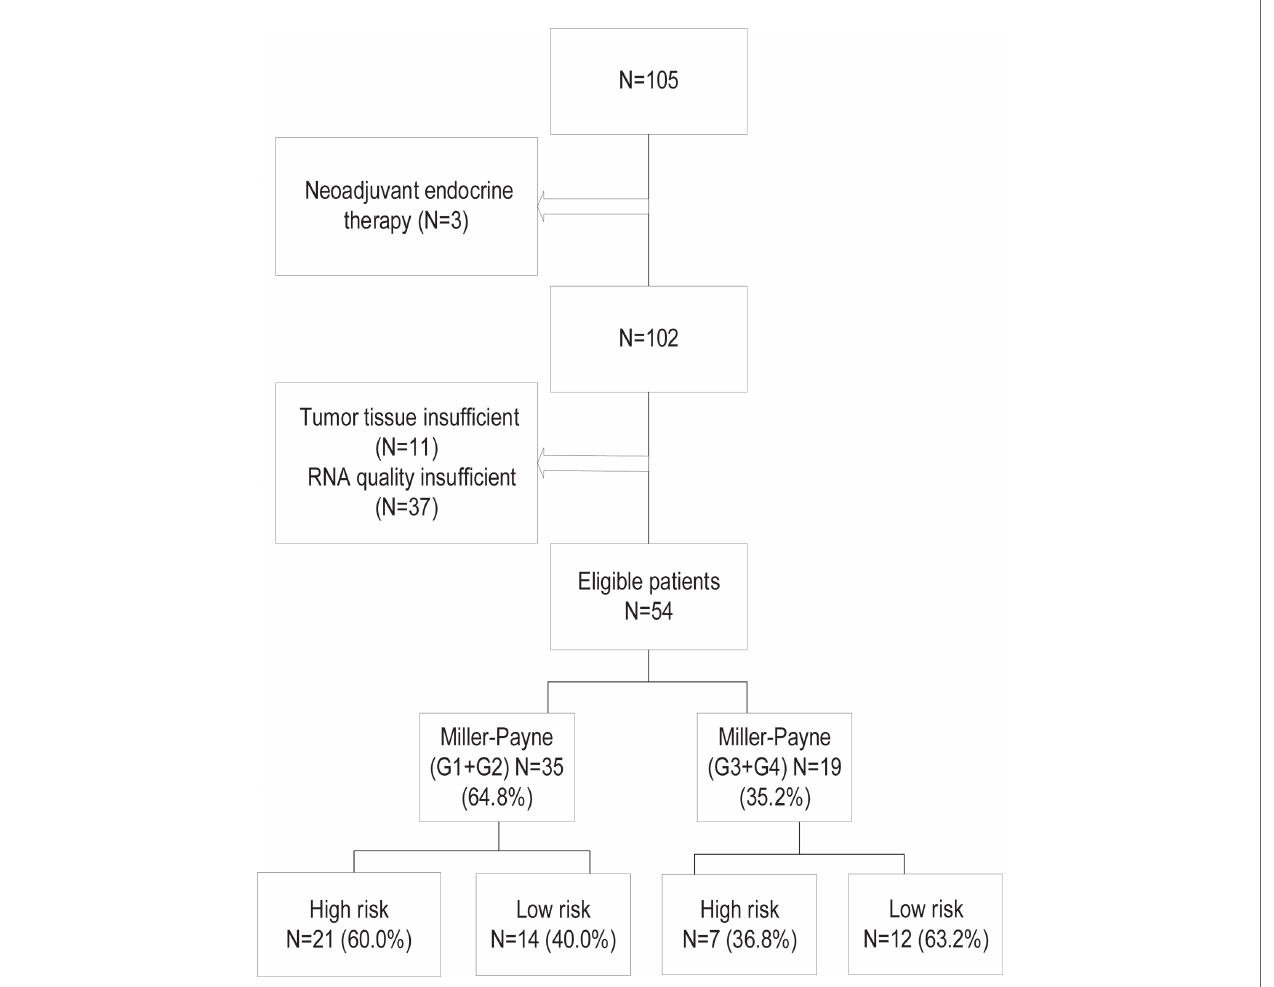
FIGURE 1 | The patient selection and the classi fi cation of the 70-gene signature and Miller – Payne pathological